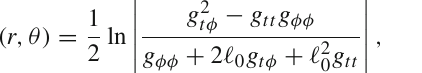
coordinates is given